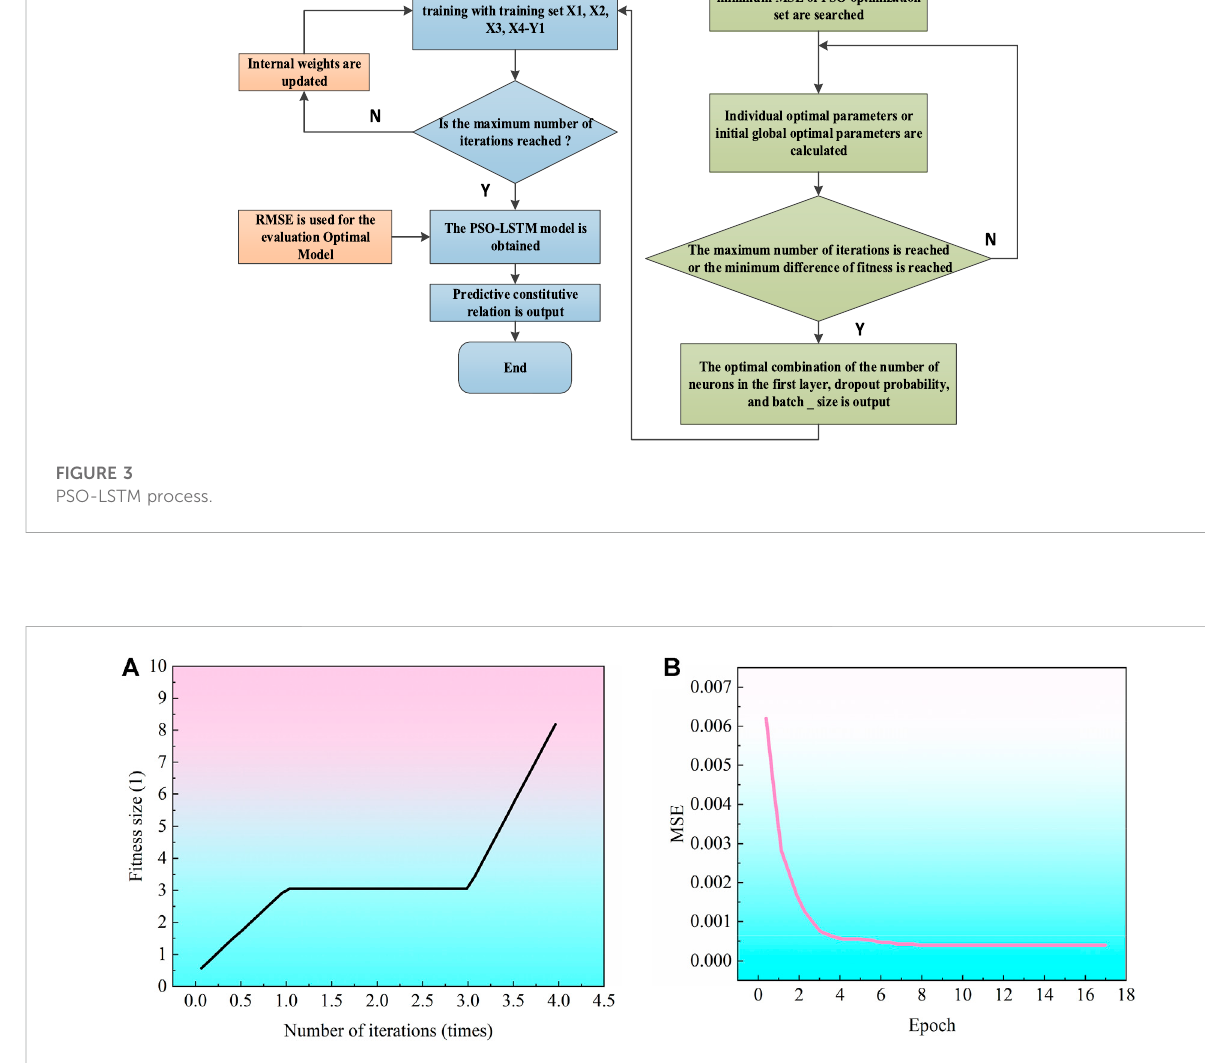
Frontiers in Earth